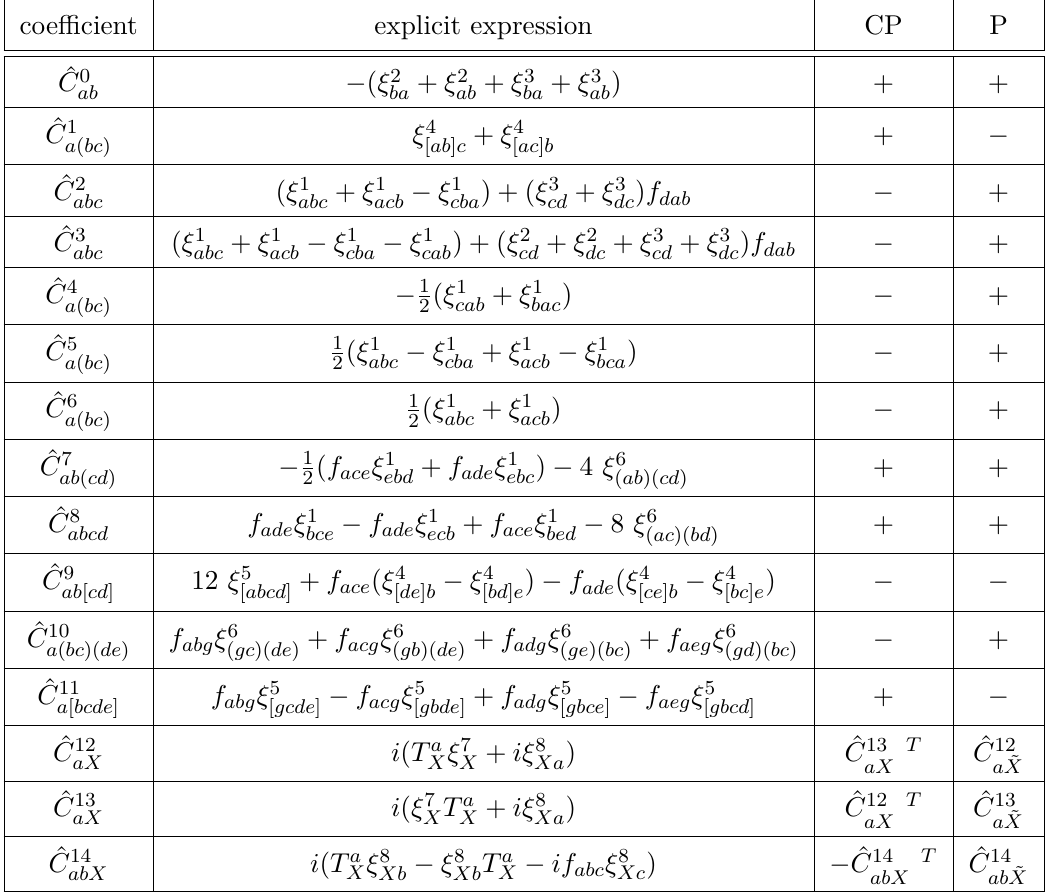
Table 3 . Coefficients appearing in the gauge variation of the general counterterm L a Γ ct once it is decomposed in the basis of table 1. Also shown are the transformation properties under CP and P. For the fermionic coefficients ˆ C 12 , ˆ C 13 and ˆ C 14 , we display their CP- and P-transformed, with aX aX abX ˜ L ( ˜ R ) = R ( L )